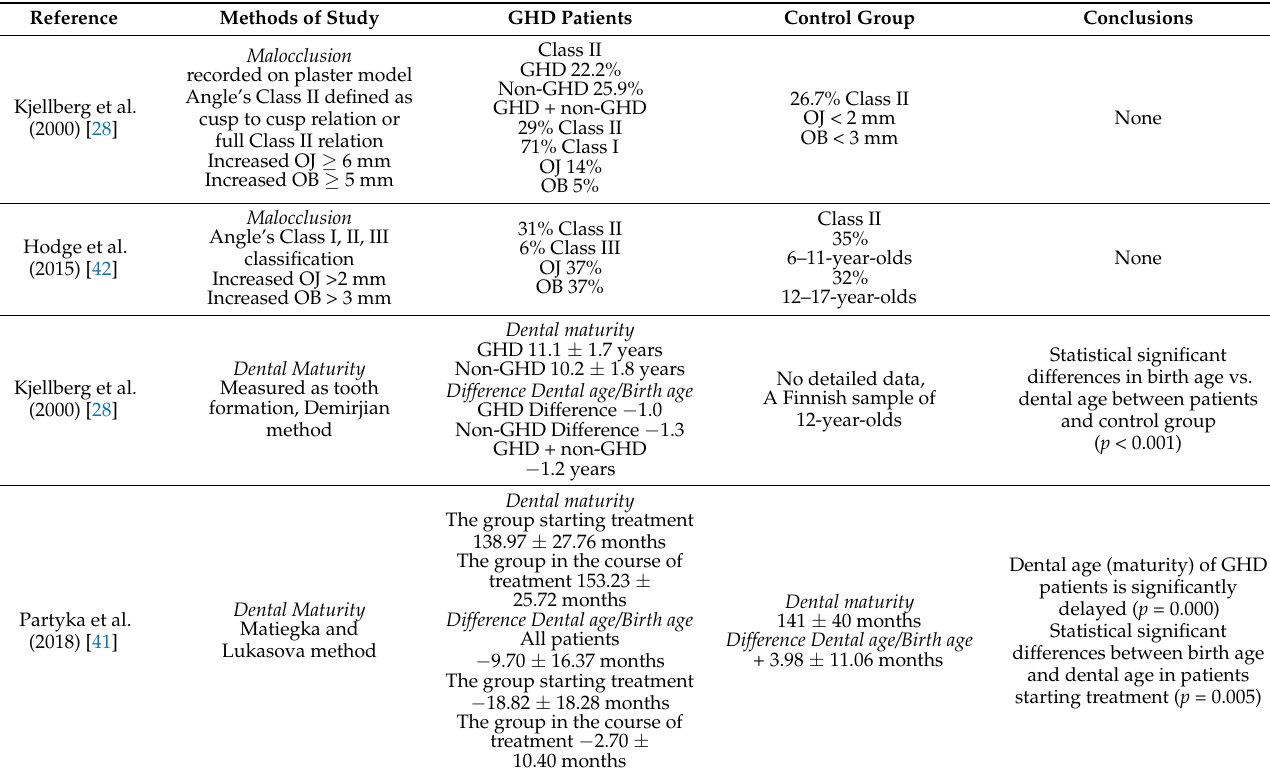
Table 3. Malocclusion and dental maturity—data abstracted from studies included in the systematic